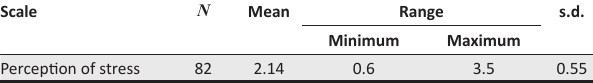
TABLE 3: Mean of nursing students’ perception of stress.